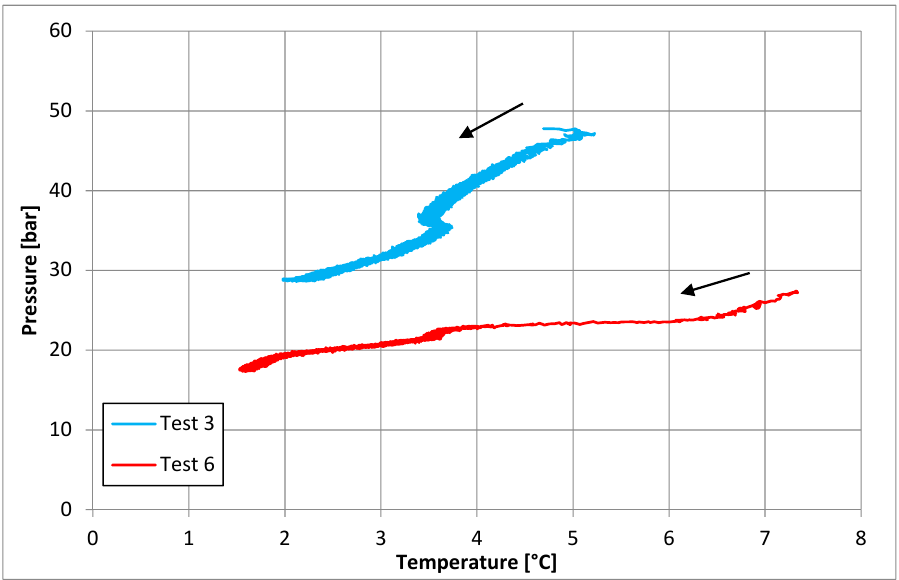
Figure 5. Comparison between Test 2, carried out using CH 4 , and Test 5, performed with CO 2 .